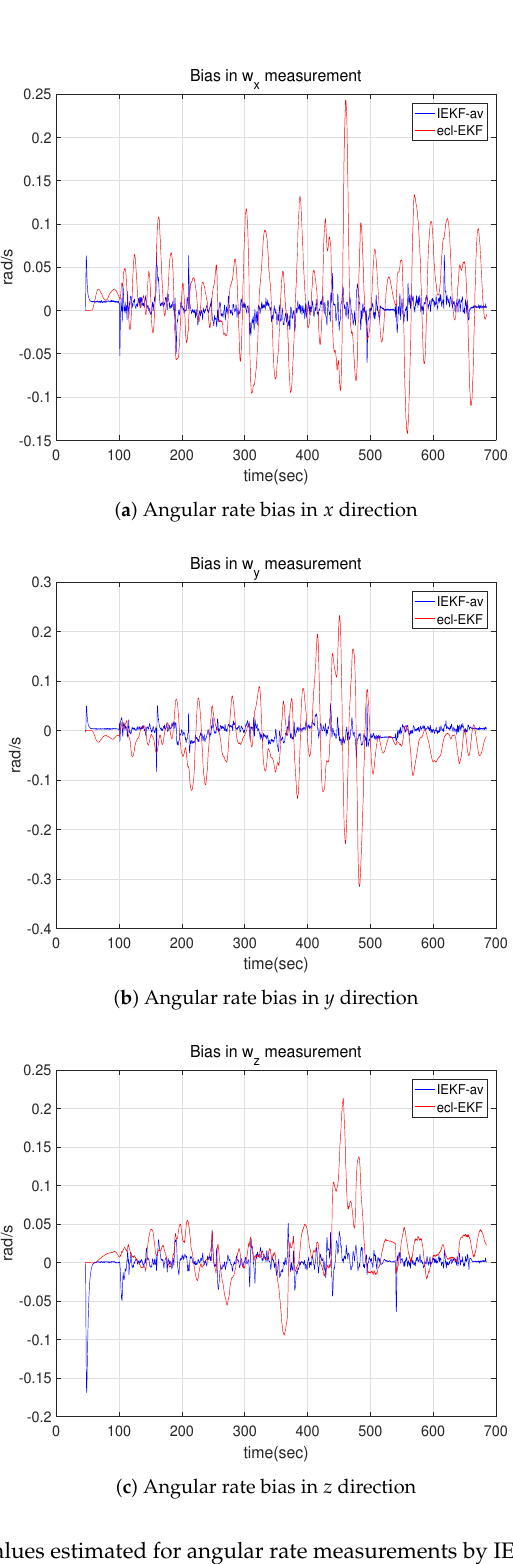
Figure 13. Bias values estimated for angular rate measurements by IEKF-av and